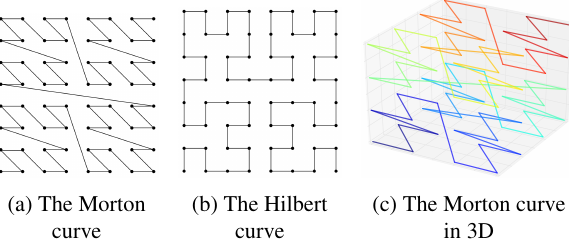
Figure 1: The Morton and Hilbert space filling